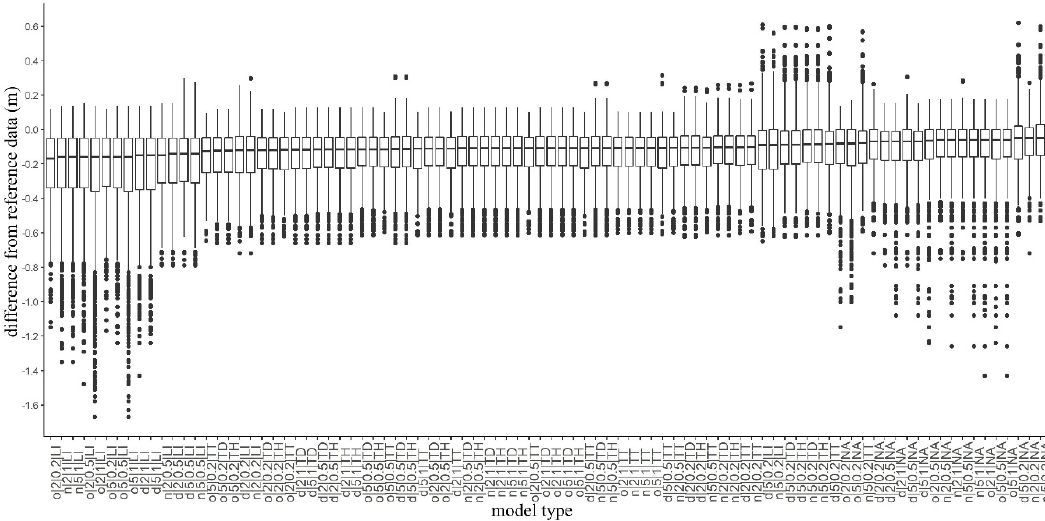
Figure 6. Boxplots of model accuracies ordered by medians for 1 m resolution (o: original database,